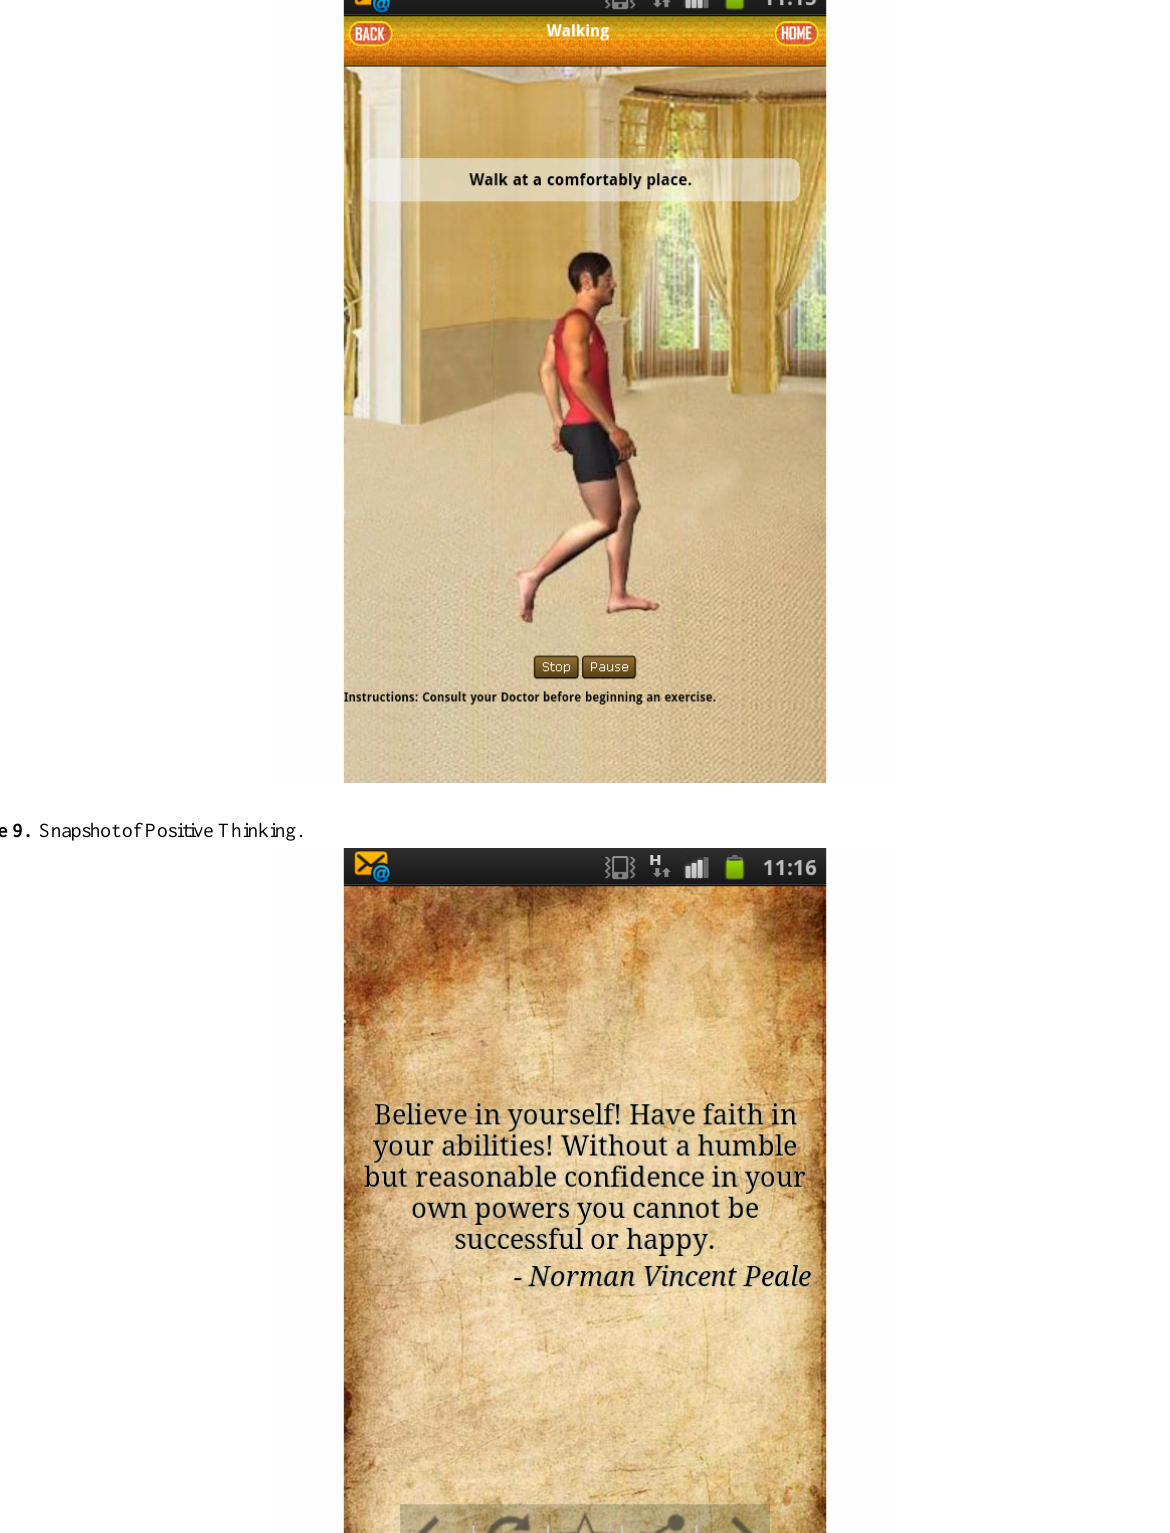
Figure 8. Snapshot of Osteoarthritis of knee.